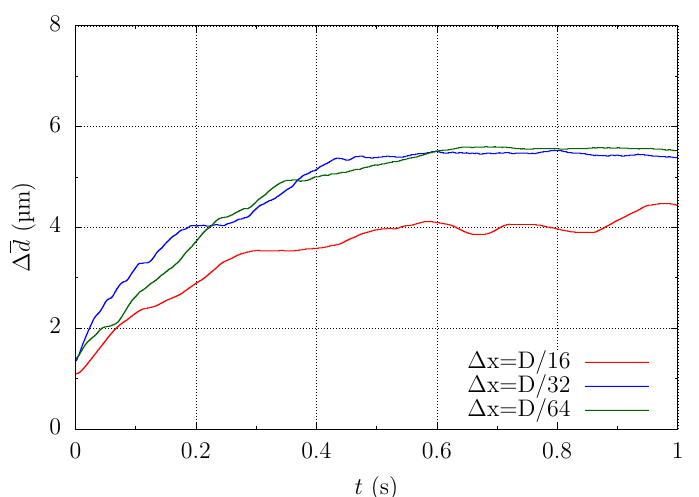
Figure A2. Dependency of particle margination on the mesh size ∆ x = D /16, D /32, and D /64. The graph shows the time history of ensemble-averaged distance ∆ d ( t ) between the particle and the centerline of the computational